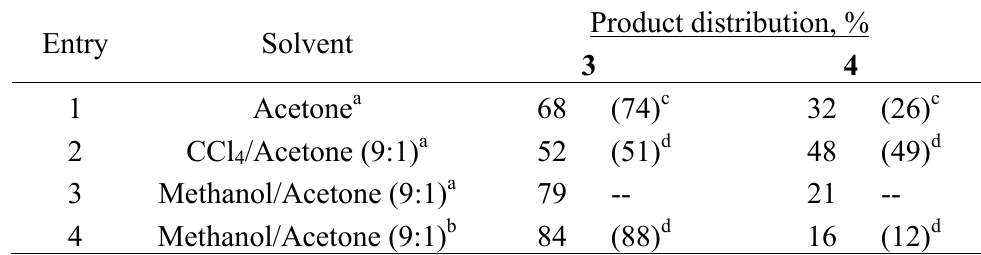
Table 1. Product distributions for the mono-epoxidation of geraniol by dimethyldioxirane at 23 ºC in various